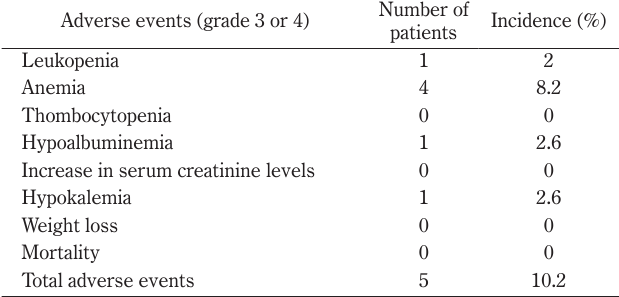
Table 2 Adverse events of S-1 plus cisplatin in the NAC (+) group (n=49)